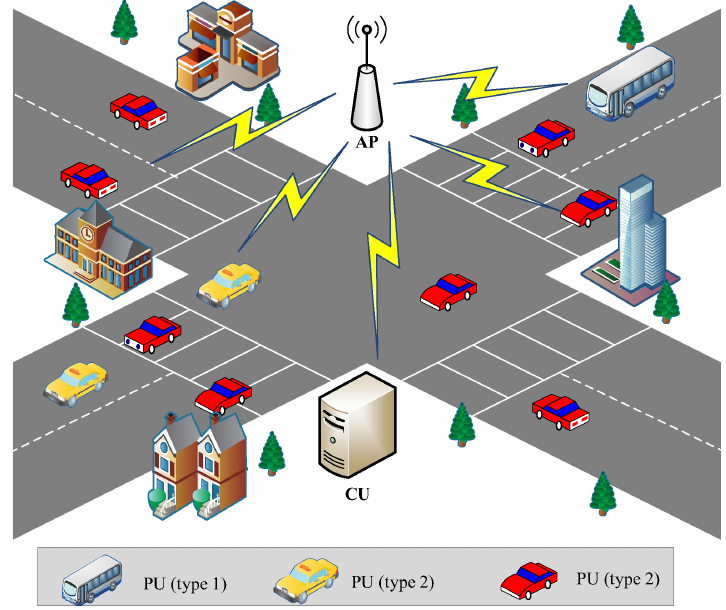
Figure 1. MCT-DLMA application in